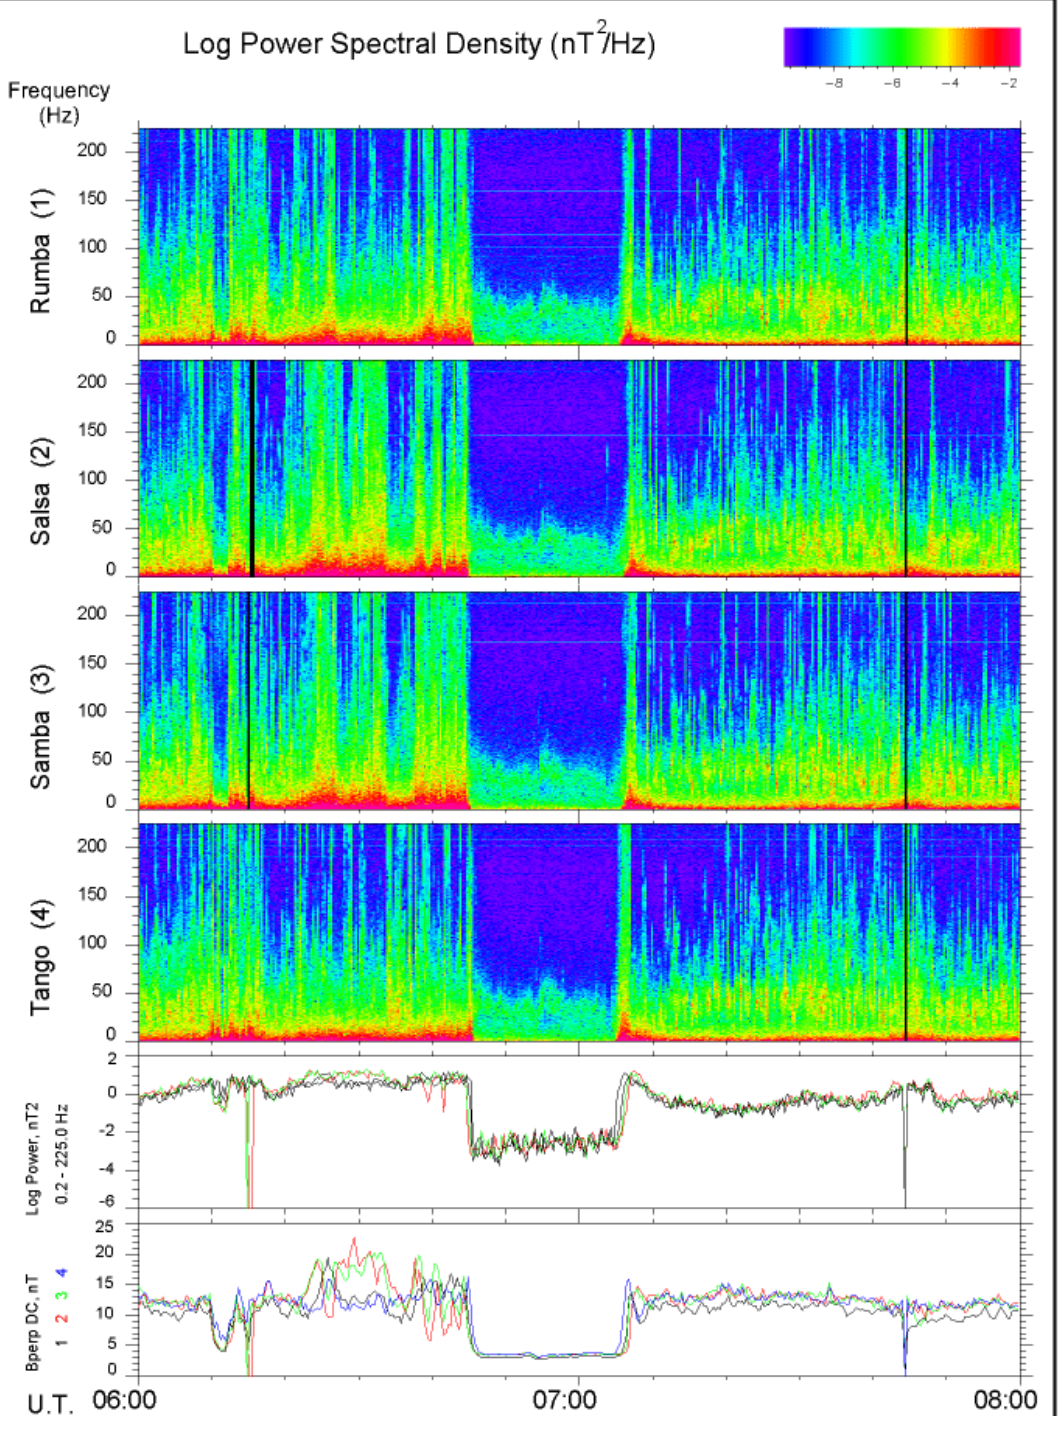
Fig. 4. An example of burst mode data, when the waveforms are sampled at 450Hz. The spectrogram gives data for the four spacecraft. Cluster crosses the Earth bow shock twice. The presentation is as described for Fig. 3. While the crossings are approximately at the same time on the four spacecraft, differences are visible both in integrated power and B field in the spin plane in the two bottom